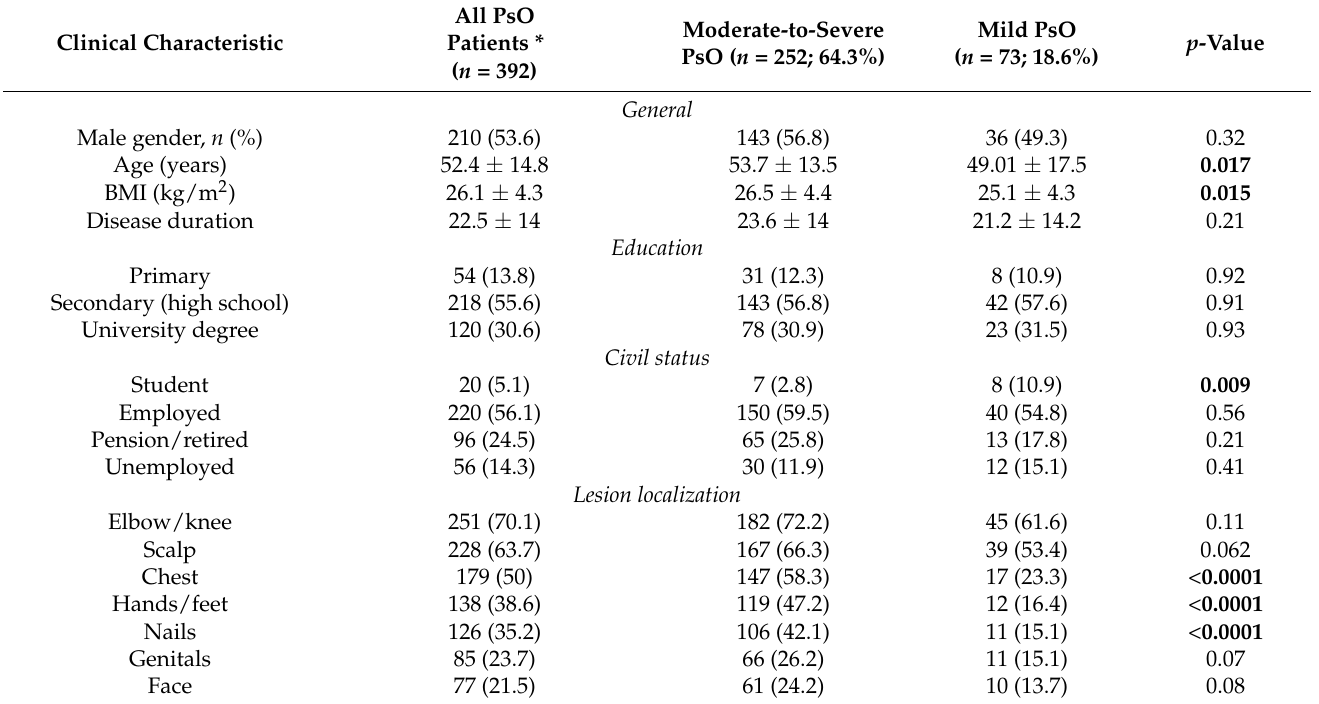
Table 1. Clinical characteristics of psoriasis